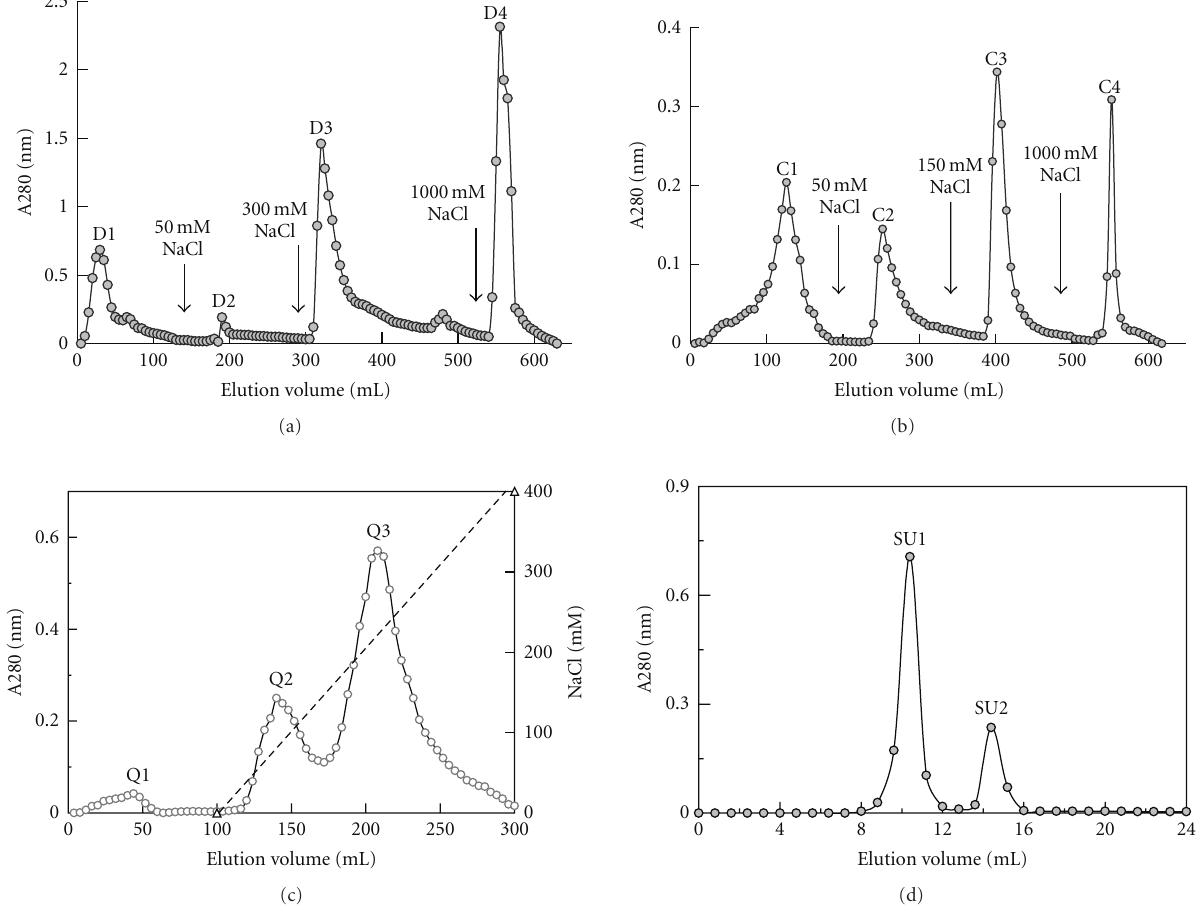
Figure 1: Elution profiles of HEA. (a) Anion exchange chromatography of protein derived from the (NH 4 ) 2 SO 4 precipitate of crude extract of H. erinaceum fruiting bodies on a DEAE-cellulose column (1 . 0cm × 20cm). which was equilibrated and eluted with 10mM phosphate- bu ff ered (pH 7.0). Arrows indicate elution of the column stepwise with 50 mM, 300mM and 1000 mMNaCl in the starting bu ff er. (b) Ion exchange chromatography of D3 on a CM-cellulose column (2 . 0cm × 15cm). Arrows indicate elution of the column stepwise with 50 mM, 150mM and 1000 mMNaCl in 10 mMNH 4 OAc bu ff er (pH 5.1). (c) Ion exchange chromatography of fraction C2 on a Q-Sepharose column (1 . 0cm × 10cm). The slanting line across the chromatogram denotes a linear NaCl concentration (0 to 400mM) gradient in 10 mMNH 4 OAc bu ff er (pH 5.1). (d) Gel filtration of fraction Q3 from Q-Sepharose column on a Superdex G-75 column, which was eluted with 10mM phosphate bu ff er (pH 7.5) containing 150mMNaCl. The flow rate was